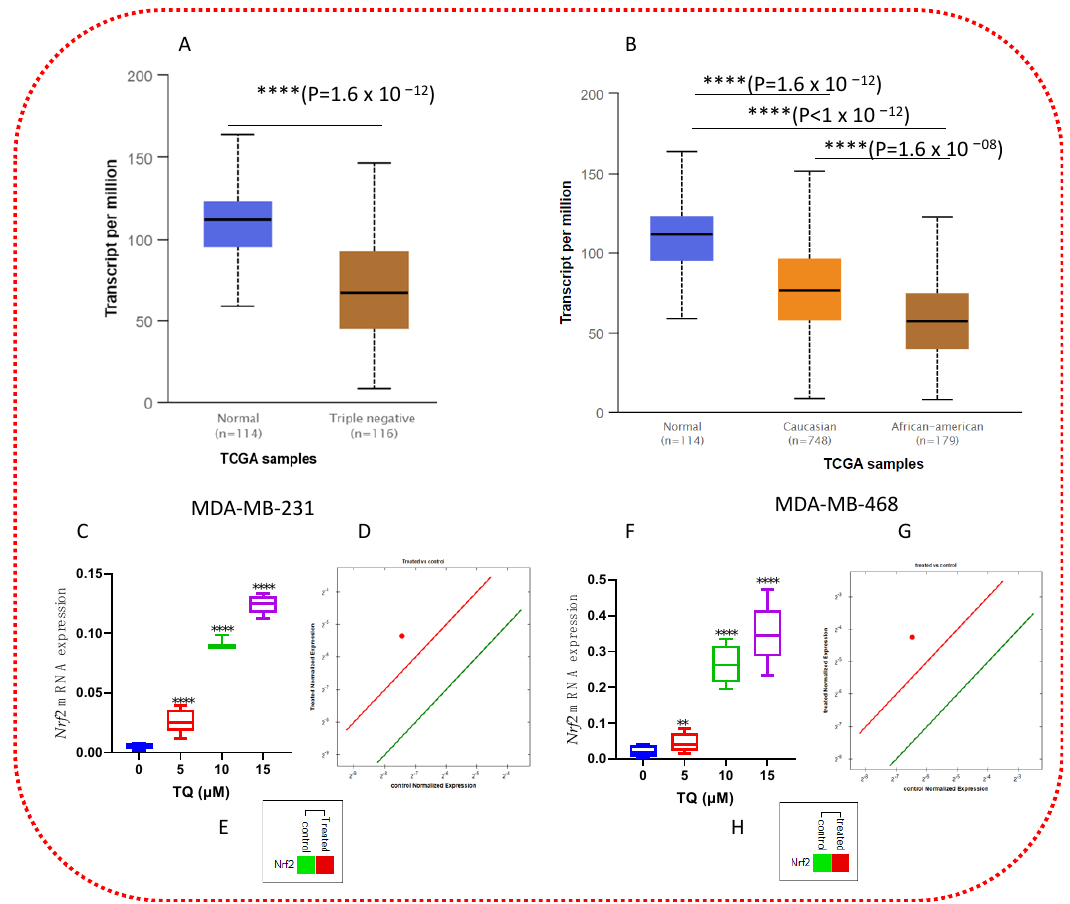
Figure 9. TQ’s effects on Nrf 2 mRNA expression. UALCAN database showed the expression of Nrf2 in BRCA based on normal breast vs. TNBC ( A ) and the expression of Nrf2 in BRCA based on the patient’s race ( B ). ( C , F ) The box and violin graph depicted the relative Nrf 2 mRNA expression after 5, 10, and 15 µM TQ treatment versus control after 24 h incubation. The red dot represents Nrf 2 upregulation at 15 µM of TQ ( D , G ). The green color represents Nrf 2 downregulation, while the red color represents Nrf 2 upregulation at 15 µ M of TQ ( E , H ). The CFX96 software was used to analyze the expression. The error bars represent the mean and the standard error of the mean. A non-parametric student t-test was used to identify significant differences ( n = 3 per treatment in four independent experiments: ** p < 0.01, **** p < 0.0001 (comparing DMSO- and TQ-treated